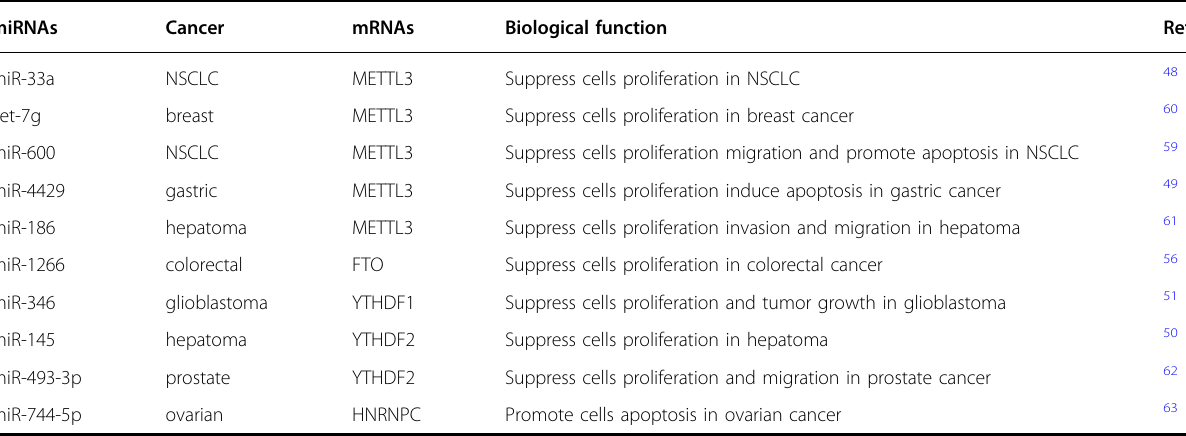
Table 2 MiRNAs regulate m6A key proteins in different cancers.